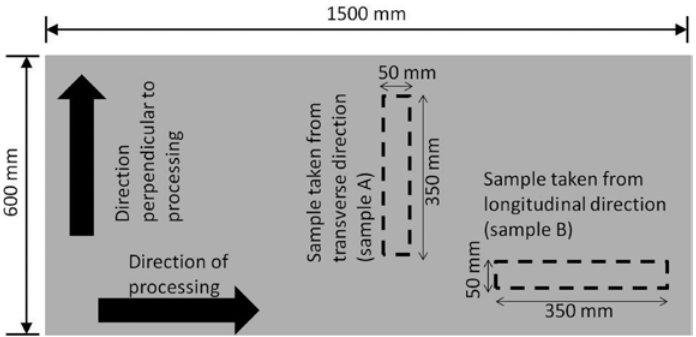
Figure 4 Schematic description of panel sampling.